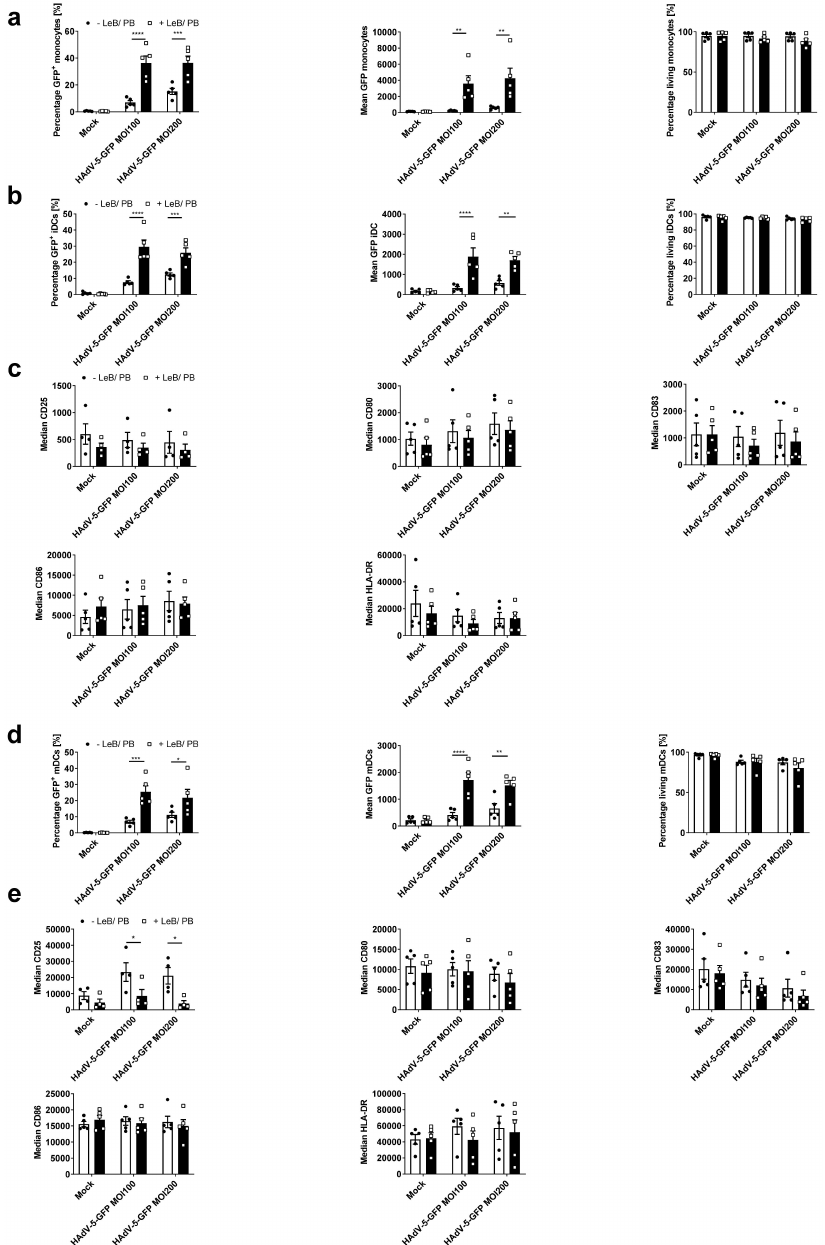
Figure 7. Human monocytes efficiently transduced in the presence of LentiBOOST ® /Polybrene can be differentiated into iDCs and mDCs. Human monocytes were transduced with HAdV-5- GFP at a MOI of 100 and 200 in combination with LentiBOOST ® /Polybrene (+LeB/PB) or water only ( − LeB/PB). Non-infected cells (“Mock”) served as a negative control. Monocytes were either immediately analyzed by flow cytometry or differentiated into iDCs for 4 days using GM-CSF and IL-4, or into day 5 mDCs, additionally adding IL-1 β , IL-6, PGE2 and TNF- α for 24 h. ( a , b , d ) Flow cytometric analyses on the percentage and mean fluorescent intensity of GFP positive as well as on 7-AAD negative living CD14+ HLA-DR+ monocytes ( a ), CD11c+ HLA-DR+ iDCs ( b ), or CD11c+ HLA-DR+ mDCs ( c ). ( c , d ) Flow cytometric analyses on cell surface markers CD25, CD80, CD83, CD86 and HLA-DR on iDCs ( c ) and mDCs ( e ). ( a – e ) Data are mean ± SEM of five independent experiments with cells derived from different healthy donors. Black circles represent conditions without LentiBOOST ® /Polybrene, white squares represent conditions with LentiBOOST ® /Polybrene. Two-way ANOVA and Sidak correction were performed. * p < 0.05, ** p < 0.01, *** p < 0.001, **** p < 0.0001, bars without annotation are not significant ( p > 0.05) in comparison to the respective